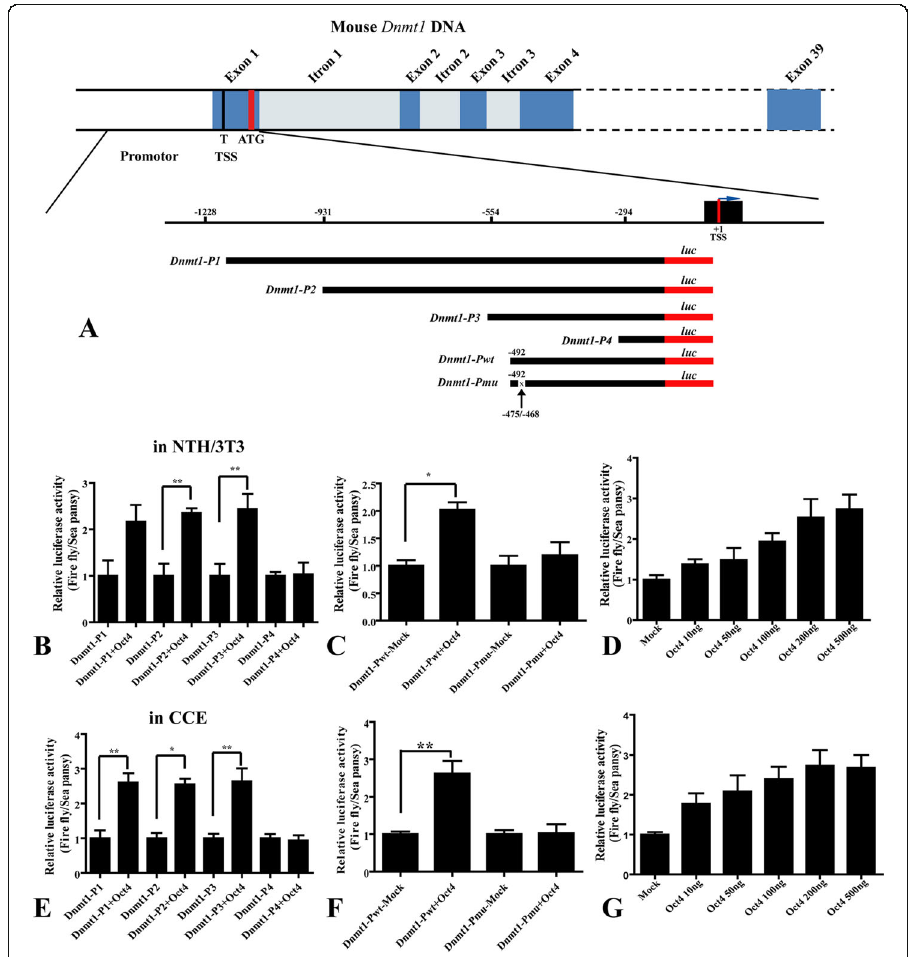
Fig. 2 Promoter analysis of mouse Dnmt1 in NIH3T3 and CCE cells using the luciferase assay. a Schematic structures of mouse Dnmt1 gene constructs used in this study. b , c , e and f – Oct4 enhanced the promoter activity of mouse Dnmt1. Oct4 -pcDNA3.1 (100 ng) plasmid was co-transfected with a series of sequential deletion constructs (Dnmt1 P1 – 4) and a mutant of the mouse Dnmt1 promoter (500 ng/well) into NIH3T3 and CCE cells. d and g 10, 50, 100, 200, and 500 ng of Oct4 -pcDNA3.1 expression plasmid was co-transfected with mouse Dnmt1- P3 promoter (500 ng/well) into NIH3T3 cells ( d ) and CCE cells ( g ). The total amount of the transfected plasmid, including the pRL-TK control vector (100 ng/well), was adjusted to 1.0 μ g with pcDNA3.1 empty vectors. Firefly and Renilla luciferase activities were measured 48 h after the transfection. The relative luciferase activity was calculated by dividing the activity of firefly luciferase by the activity of Renilla luciferase. The data are presented as the means ± SD for triplicate